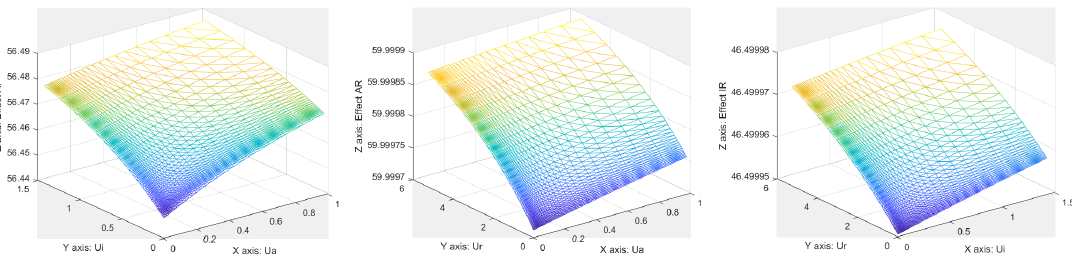
Figure A6. Surface responses obtained for γ = 4 for each drug